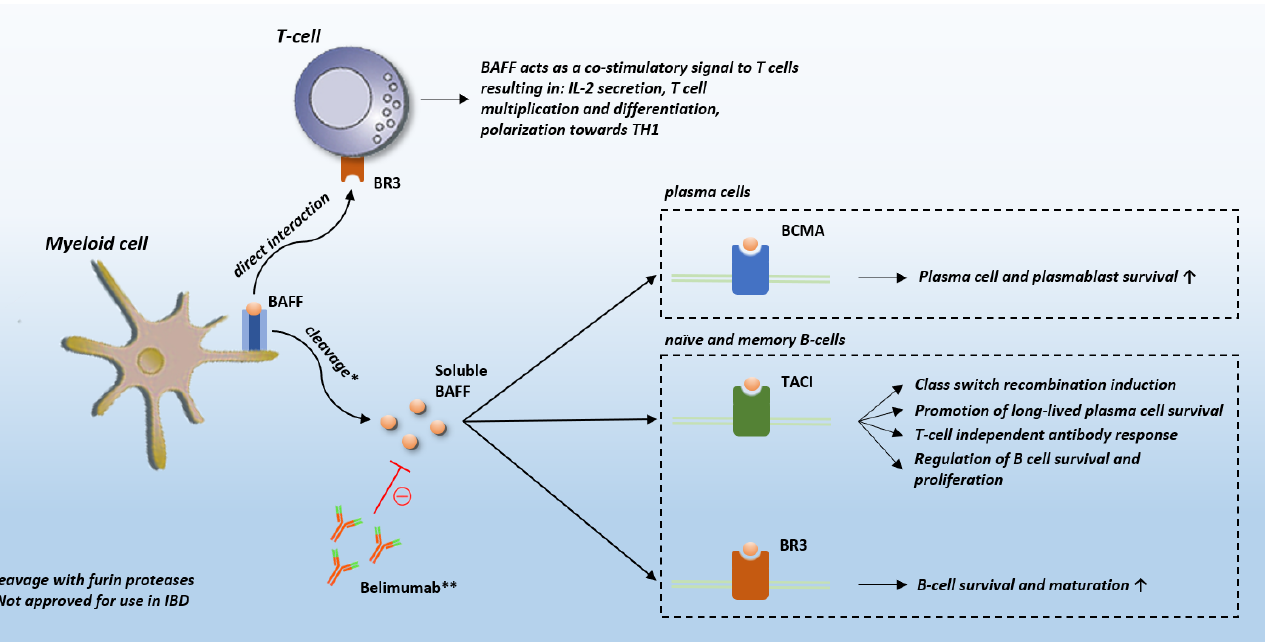
Figure 1. BAFF receptors. Abbreviations: BAFF: B-cell activating factor; BCMA: B cell maturation antigen; TACI: transmembrane activator and calcium-modulating and cyclophilin ligand interactor; BR3: BAFF-receptor; IBD: inflammatory bowel disease; IL-2: interleukin 2.